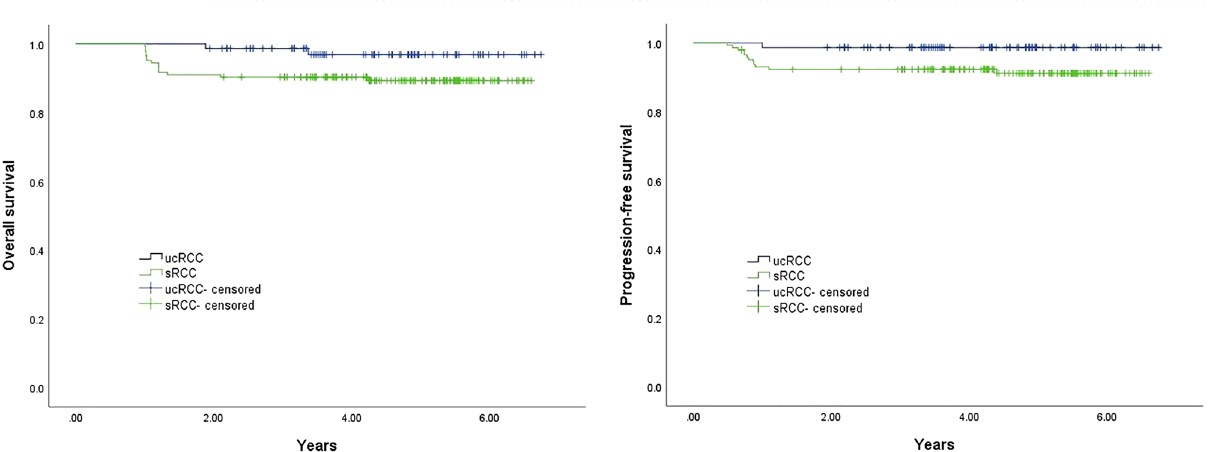
Figure 4. Kaplan–Meier curves of overall and progression-free survival for unilocular cystic and solid RCC.